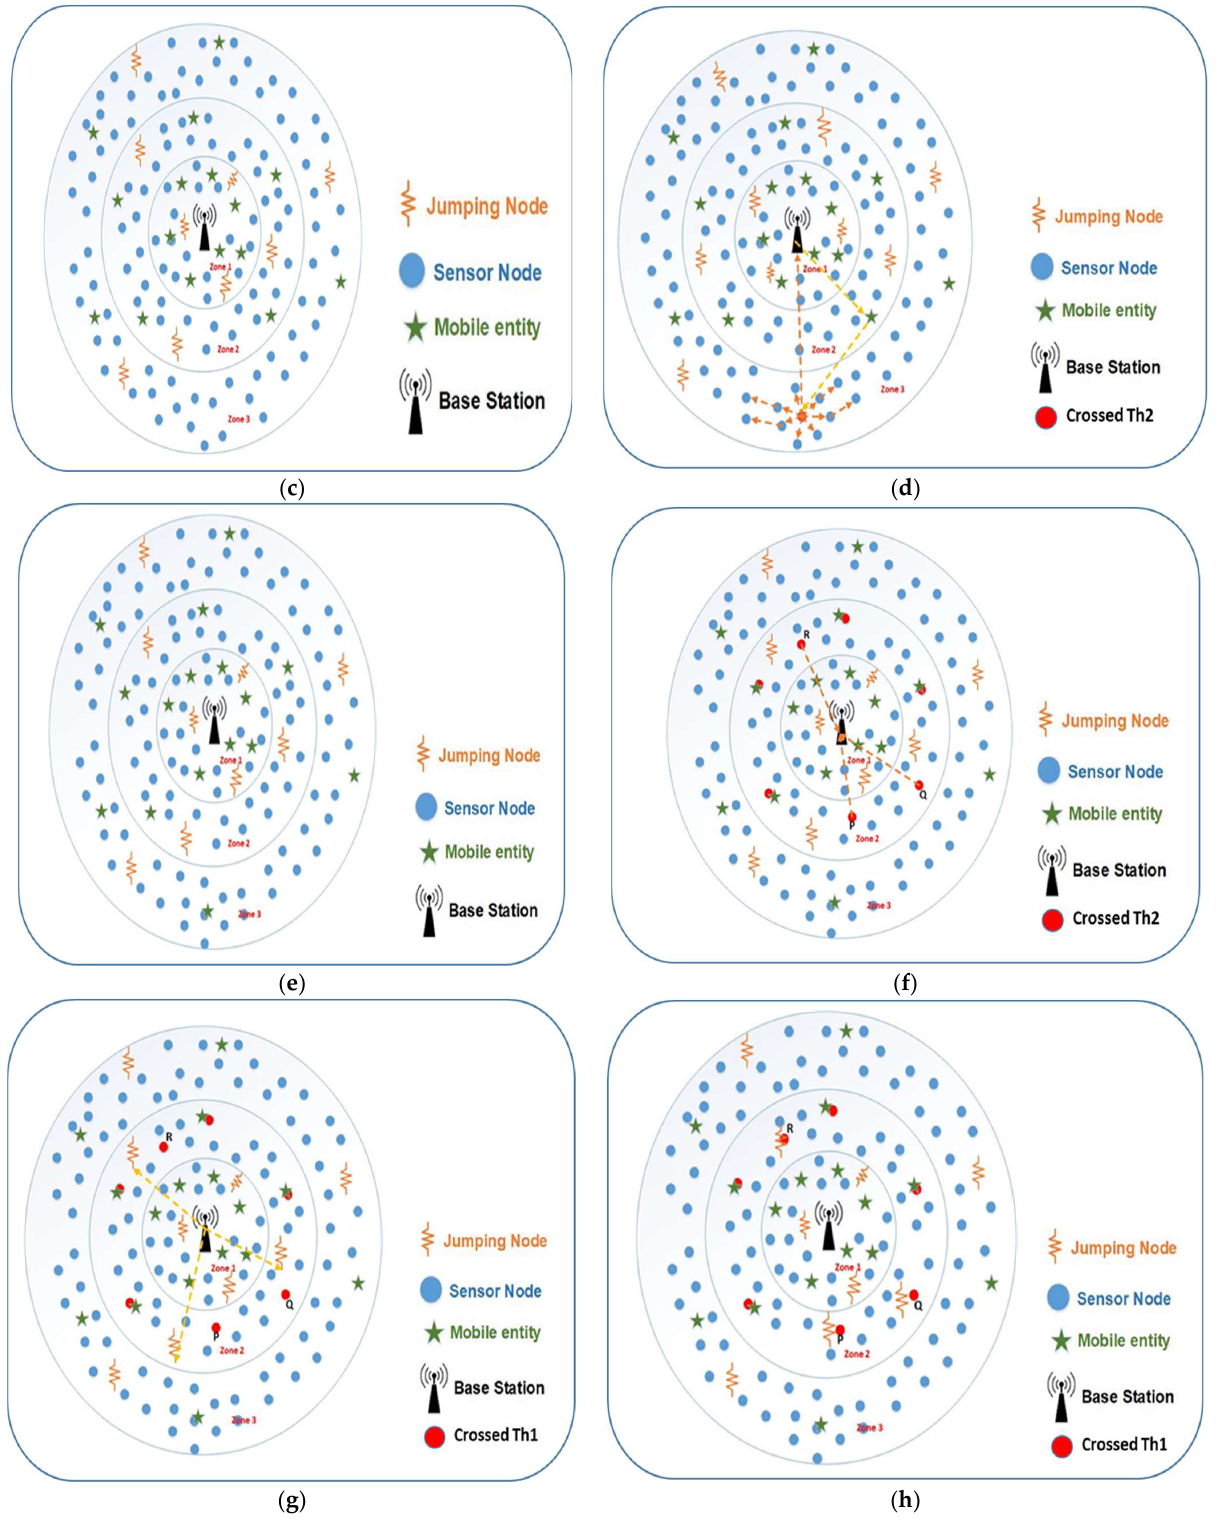
Figure 1. An example that illustrates overall operation of proposed methodology: ( a ) proposed system; ( b ) ME in neighbouring nodes; ( c ) ME awaited arrival at station charge; ( d ) sensor node send message to base station; ( e ) sensor node being charge; ( f ) failure of many nodes; ( g ) jumping nodes being alerted; ( h ) backup received.